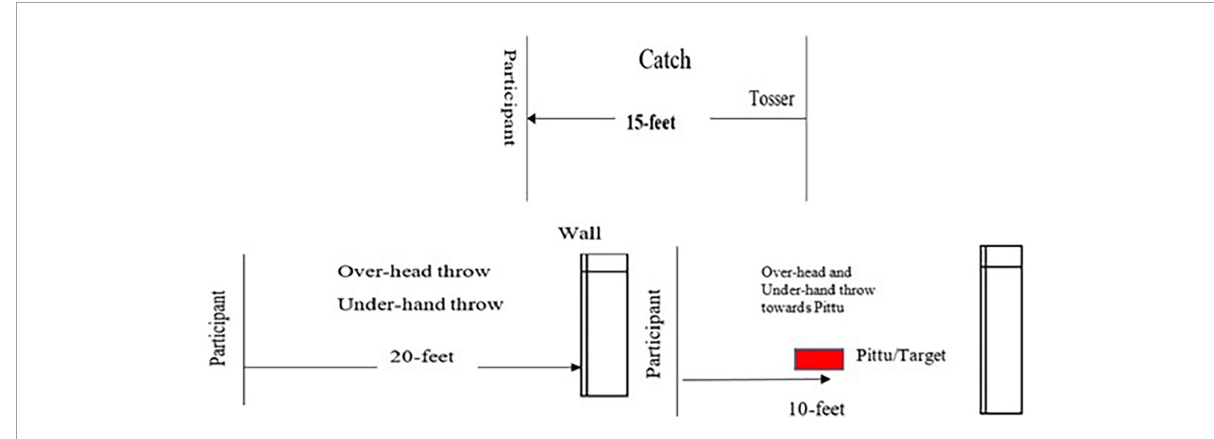
FIGURE1 Layout of skill performance test for catch, overhead throw, underhand throw, and overhead/underhand throw towards Pittu .